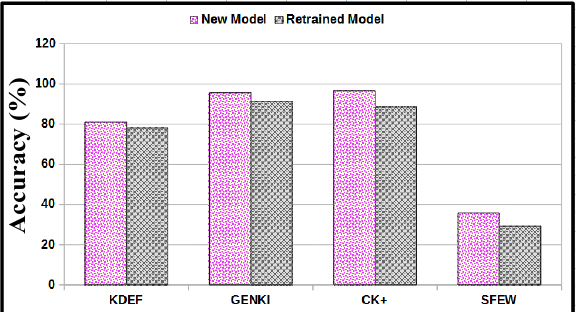
Figure 14. Effect of transfer learning on the performance of the proposed FERS.